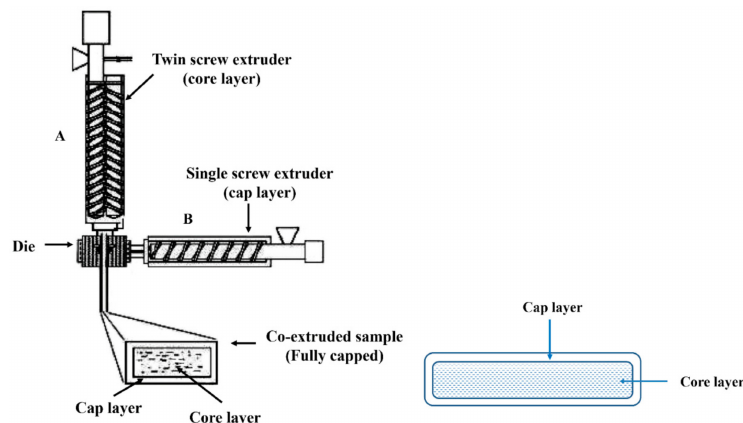
Figure 1. Schematic of the coextrusion system and a cross section diagram of wood flour plastic composites with a core-shell structure